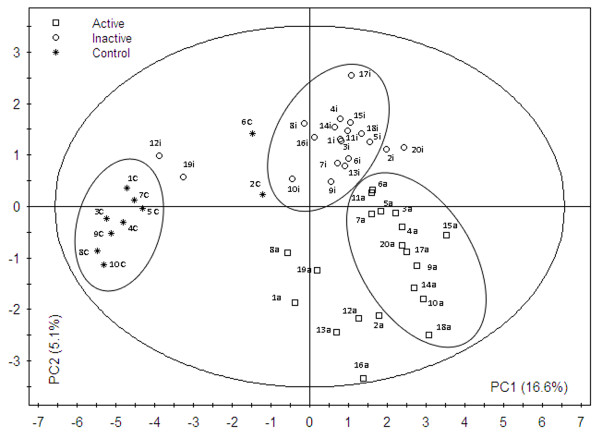
TTGE profiles PLS-DA model. PLS-DA score plot of TTGE bands profiles from CD patients, during both active and inactive celiac disease, and controls. In brackets are the percentages of total variation of the dataset explained by the first two components PC1 and PC2. The major ellipse represents Hotelling's T2 range at 95% confidence for the entire dataset (T2dataset = 6.51), whilst minor ellipses represent Hotelling's T2 range at 95% confidence for every single group (T2active = 2.45, T2inactive = 1.88, T2control = 1.52). The predictability of PLS-DA model was 88%, with a Fisher's test P value of 5.3*10-8.